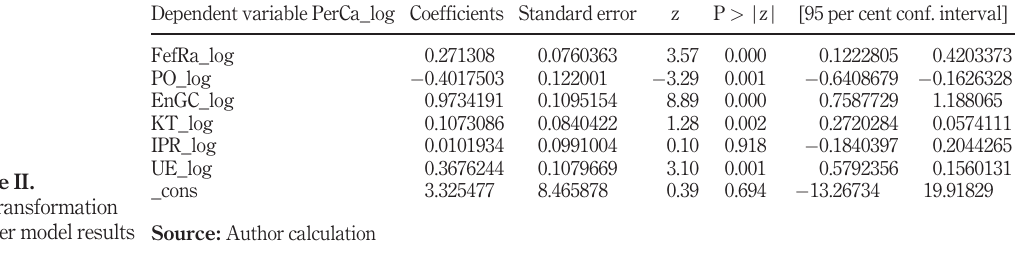
Table I. Consistent estimation of fi xed-effects stochastic frontier model